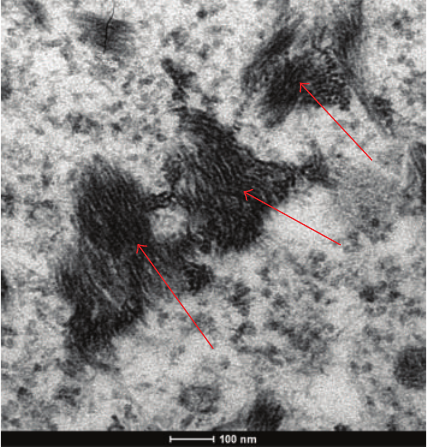
Figure 2: TEMimages of a fibroblast present in a healed skinsample treated with AgNP based medical devices. Nanoparticles taking up by endocytosis. AgNps in normal human dermal fibroblasts take up AgNps (red arrows) by endocytosis (blue arc).